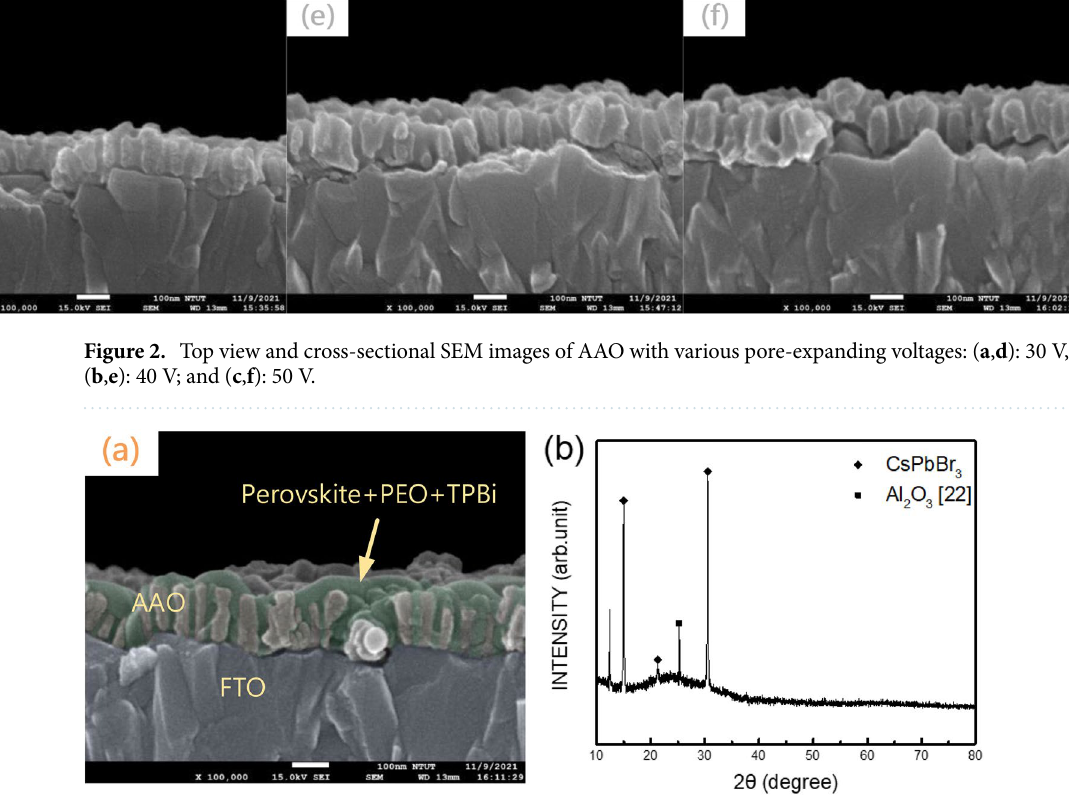
Figure 4 plots the absorbance and photoluminescence (PL) spectra of the CsPbBr 3 perovskite film on and in AAO films. The absorption edges of the CsPbBr 3 perovskite film with and without AAO films are 510 nm (2.431 eV) and 514 nm (2.412 eV), respectively, and the peaks of the PL spectrum of the CsPbBr 3 perovskite film with and without AAO films are 518 nm (2.394 eV) and 522 nm (2.375 eV), respectively. The blue-shift of approximately 8 nm between the absorbance and PL spectra for the CsPbBr 3 perovskite film with and without AAO films may be due to the Stoke shift 22,23 . The energy shift between absorbance and PL spectra is 37 meV, 3 kT , where k is Boltzmann constant, and T is temperature). Therefore, the Stoke shift of corresponding to the 2 8 nm is caused by the thermal energy form the excitation laser. The blue-shift of approximately 4 nm for the CsPbBr 3 perovskite film with and without AAO films may be caused by the pore size effect caused by the bandgap modulation 23–25 . Figure 5a sketches the diagram of the electron level of the CsPbBr 3 PeLED in this work. Figure 5b plots the electroluminescence (EL) spectra of the CsPbBr 3 PeLEDs with and without the AAO structure for various pore-expanding voltages. The inset of Fig. 5b is a photo of the CsPbBr 3 PeLED with an AAO structure and a pore-expanding voltage of 50 V operating at a bias of 6 V. The peak position of the EL spectrum of the CsPbBr 3 PeLED without an AAO structure is 514 nm. The peak position of the EL spectrum of CsPbBr 3 PeLEDs with an AAO structure with 30 and 40 V of pore-expanding voltages is 510 nm. The peak position of the EL spectrum of the CsPbBr 3 PeLED with an AAO structure with a 50 V pore-expanding voltage is 512 nm. The blue-shift